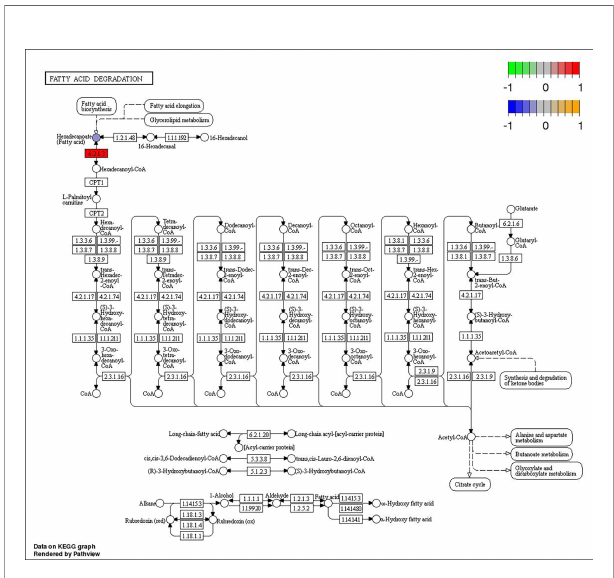
FIGURE 4 | Changes in the fatty acid degradation pathway in Ctenopharyngodon idella brain after MS-222 high-concentration